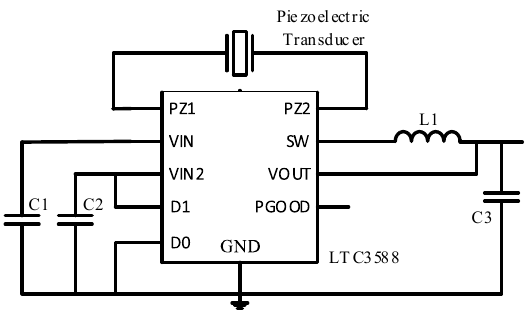
Figure 16. Energy harvesting circuit.